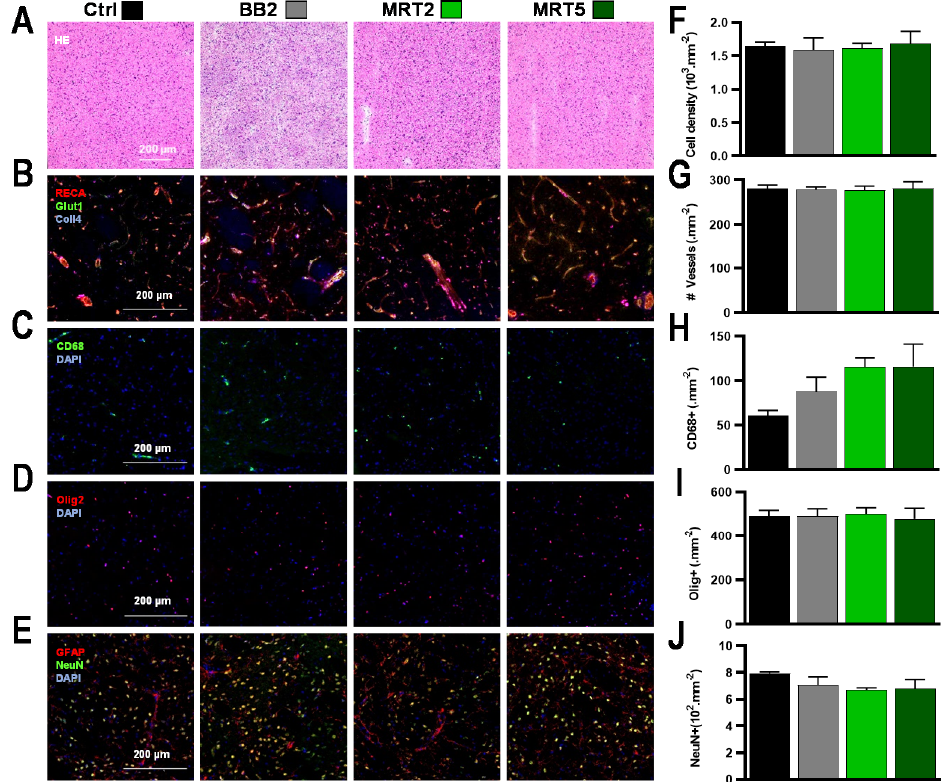
Figure 2. Pathology and quantitative immunolabeling characterization of irradiation effects at 12 months after irradiation of normal rats. ( A – I ) No histopathologic alterations were seen in collateral areas where the deposited dose was subdivided in single-beam trajectories (5 Gy BB2, 5/376 Gy MRT2 valley/peak dose, 2/137 Gy MRT5 valley/peak dose), for ( A ) H&E staining, ( B ) Collagen − 4, RECA-1, Glut-1 immunolabeling, ( C ) CD68 reactivity, ( D ) Olig2 staining, and ( E ) NeuN-GFAP dual-labeling. The same results between groups were obtained for quantitative analysis of ( F ) total cell density and ( G ) number of blood vessels, while ( H ) the density of CD68-positive cells moderately increased after multiport MRT. In contrast, the same ( I ) oligodendrocyte and ( J ) neuronal densities were found in all groups.